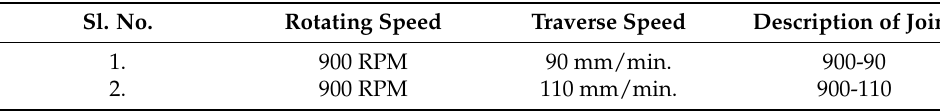
Figure 2. Friction stir welding tool. Table 1. Terminology used for welded plates.